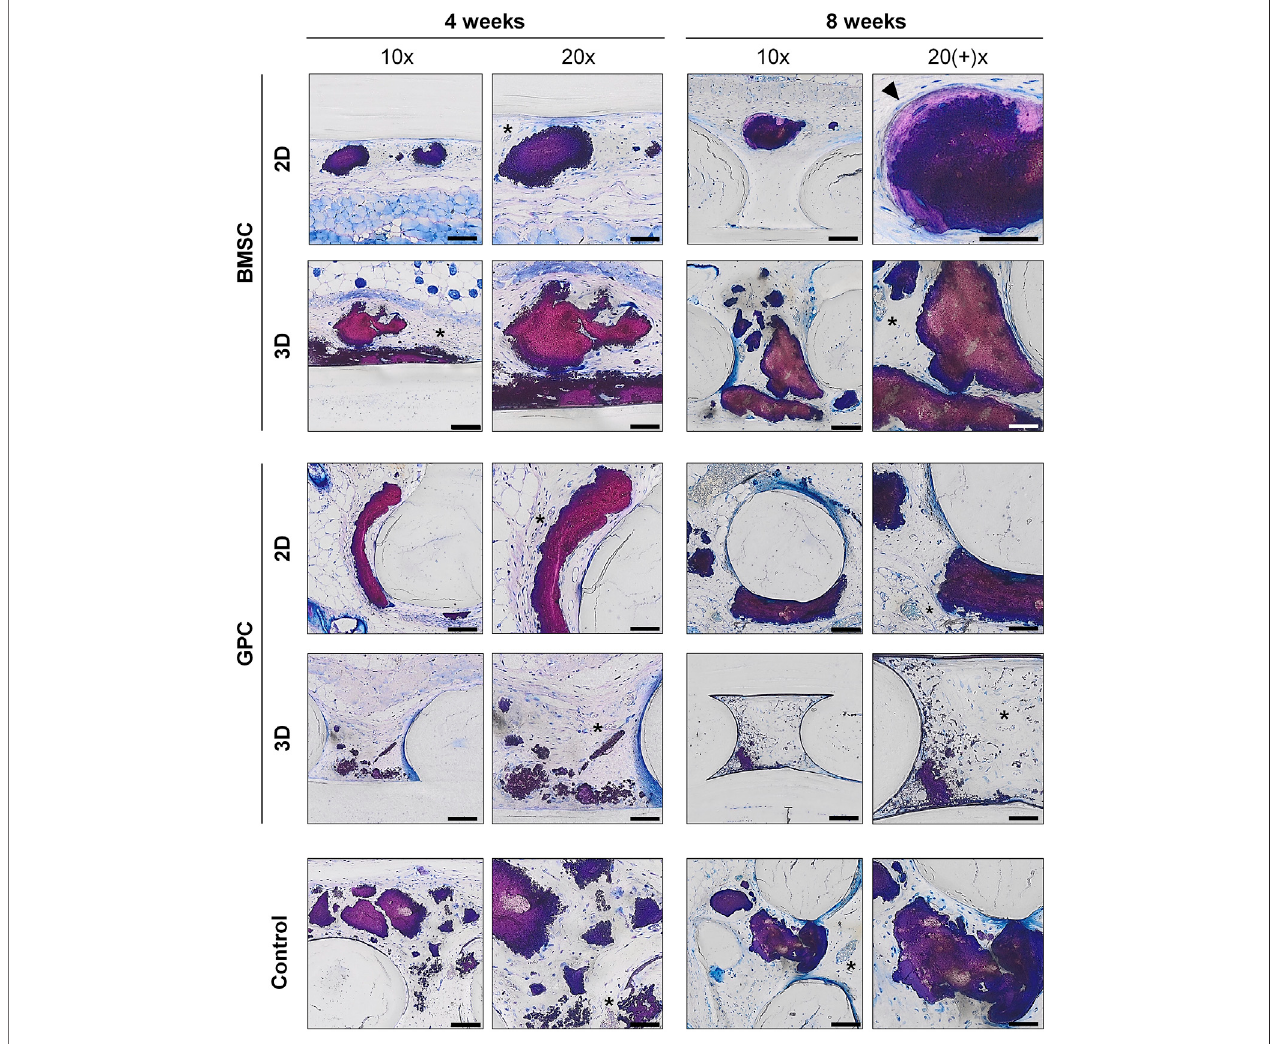
FIGURE7| Undecalci fi ed histology. RepresentativeimagesofBMSC, GPC and controlconstructs(no cells) after 4and 8 weeks(thin ground sections, Levi Lazko staining); * indicate blood vessels; arrow indicates the only instance of “ bone-like ” tissue observed in the study; scale bars 100 μ m (10x) and 50 μ m (20x).